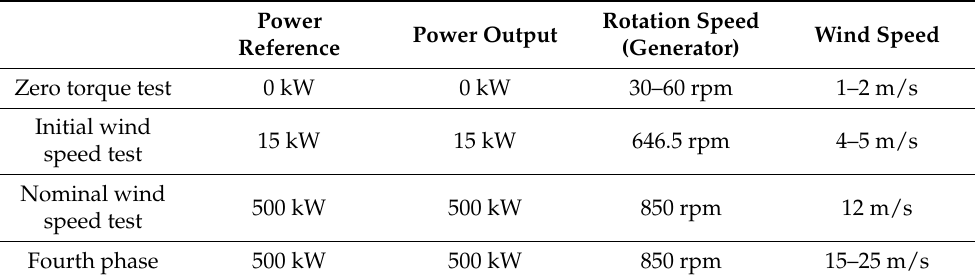
Table 6. Wind turbine on-site experiment